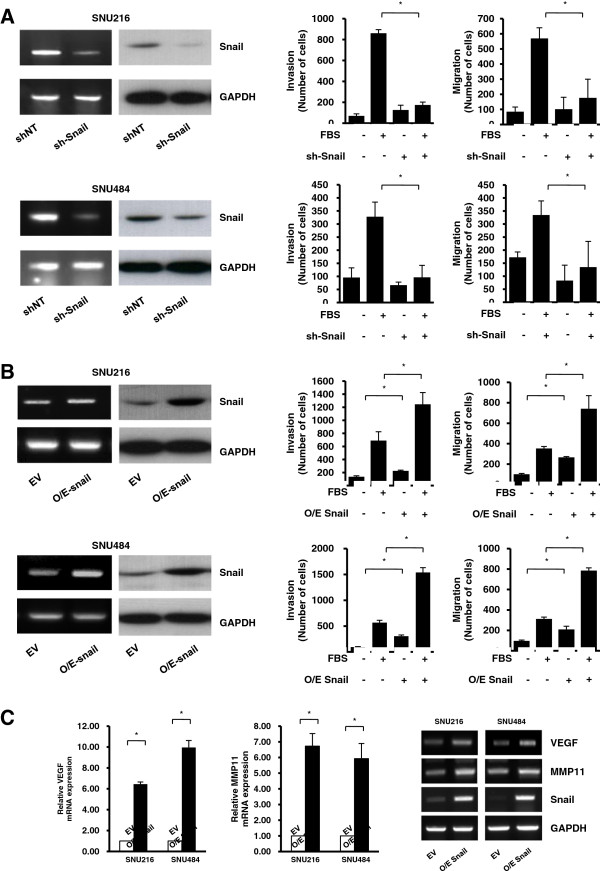
Role of Snail in invasion and migration of gastric cancer cell lines. A. SNU216 (upper panel) and SNU484 (lower panel) cells were infected with lentiviruses expressing either non-target shRNA (shNT) or Snail shRNA on day 0, and then harvested on day 7 post-infection. Snail knockdown was determined by RT-PCR and western blotting; stable cell lines were generated for each of the cell lines (sh-Snail). Silencing of Snail in SNU216 and SNU484 cells induced decreased migration and invasion. B. SNU216 (upper panel) and SNU484 (lower panel) cells were infected with lentiviruses expressing either a lentiviral PLKO vector targeting Snail or an empty PLKO vector (EV) on day 0, and then harvested on day 7 post-infection. The overexpression of Snail was determined by RT-PCR and western blotting; stable cell line was generated for each of the cell lines (O/E-snail). Snail overexpression in SNU216 and SNU484 cells induced increased migration and invasion. C. Snail overexpression induced increased mRNA expression of VEGF and MMP11 in SNU216 and SNU484 cells in real-time RT-PCR analysis. Lower panel indicates representative RT-PCR figures for VEGF, MMP11, Snail, and GAPDH. Data show the mean ± SE of at least 3 independent experiments. * indicates P < 0.05 by Student’s t-test.